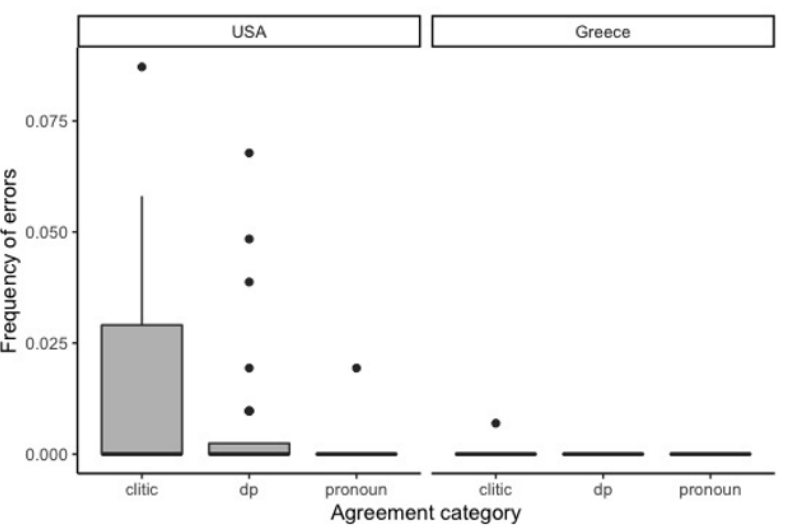
Figure 7. Normalized frequency of errors for each agreement category (clitic, DP internal, pronoun) per country (USA, Greece) within the adolescents’ group.